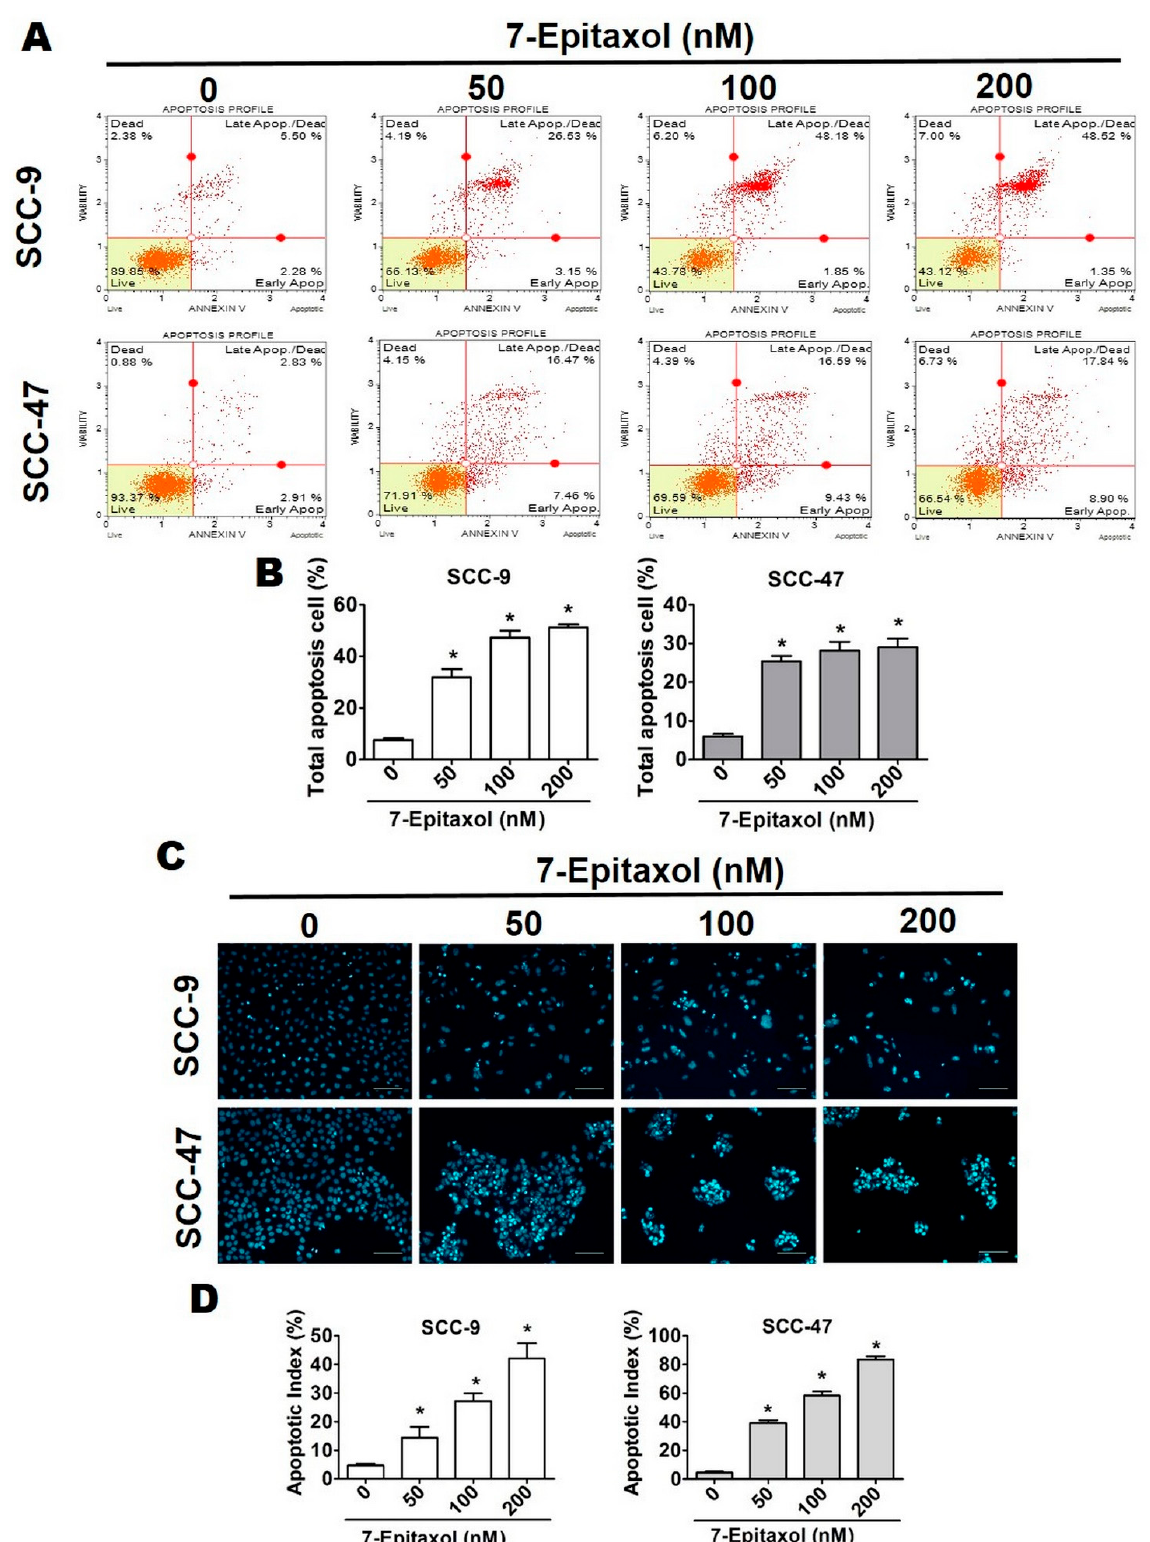
Figure 3. 7-Epitaxol induces apoptosis in SCC-9 and SCC-49 cells. After treatment with 7-E (0–200 nM) for 24 h: ( A ) Cells were stained with Annexin V/PI and flow cytometry revealed 7-E induced apoptosis. ( B ) Quantitative relative percentages of apoptosis cells (including early and late states). ( C , D ) We used DAPI stain assay to determine DNA condensation with fluorescence microscopy. Bar scale = 100 µ m. Data are presented as mean ± SD ( n = 3). * p < 0.05, compared with the control